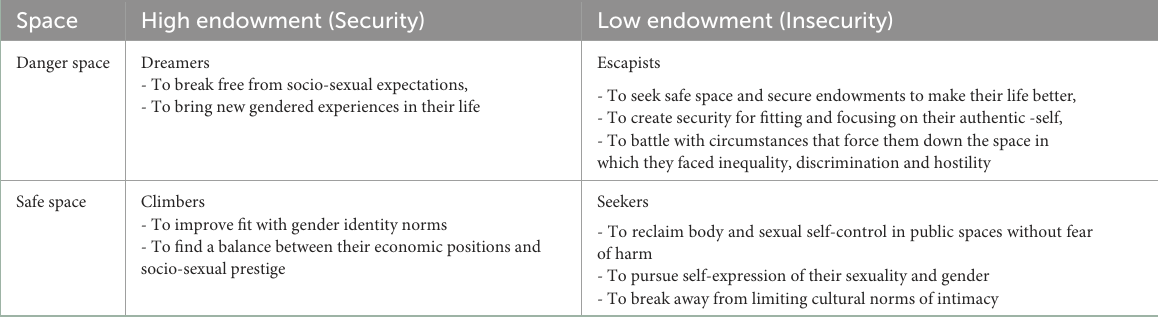
TABLE 2 Locating sexuality as a migration reason for four archetypes of migrants in terms of sexuality, security, and space. Space High endowment